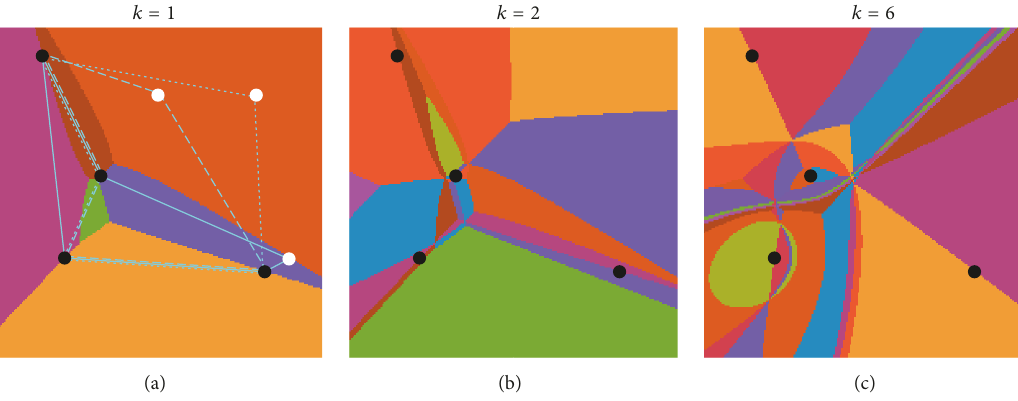
Figure 6: Stability areas for different trajectories . (a) rTSP with 𝑁 = 5 , 𝑛 = 1 , and three possible reallocations of the white point. The shortest trajectory, 𝑘 = 1 , is indicated as a solid, dashed, and dotted line, corresponding to the three reallocations. Regions of varying color correspond to different trajectories for 𝑘 = 1 (see Figures 4(a), 4(b), and 4(c)). In panels (b) and (c) we show a plot with the same fixed sites as in (a), but for 𝑘 = 2 and 𝑘 = 6 , respectively.